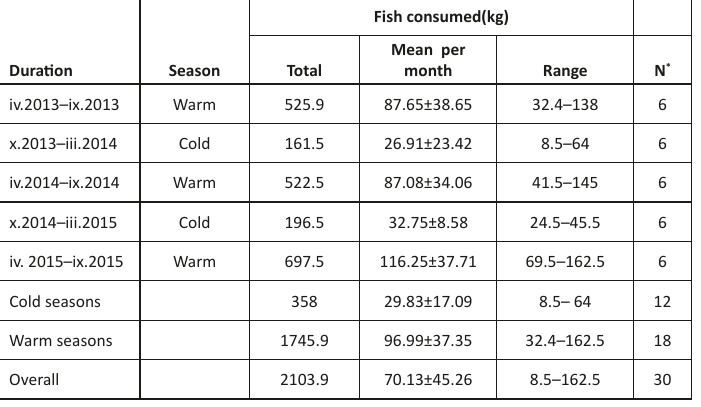
Table 3. Amount of fish consumed by 20 Gharials in warm and cold seasons from April 2013–September